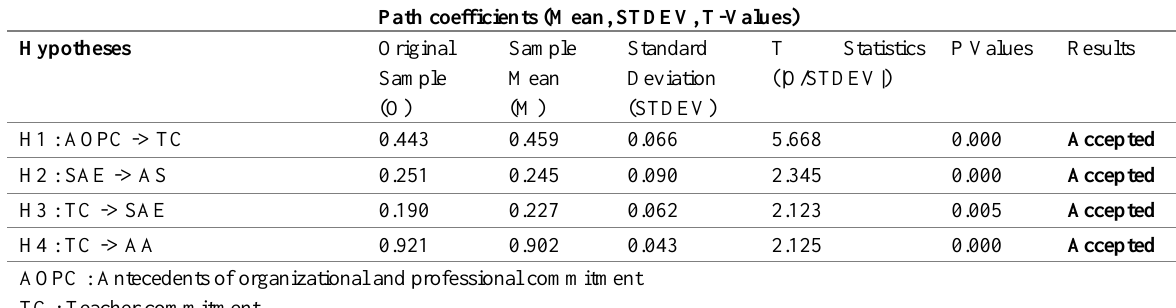
Table 9: Result of validation of research